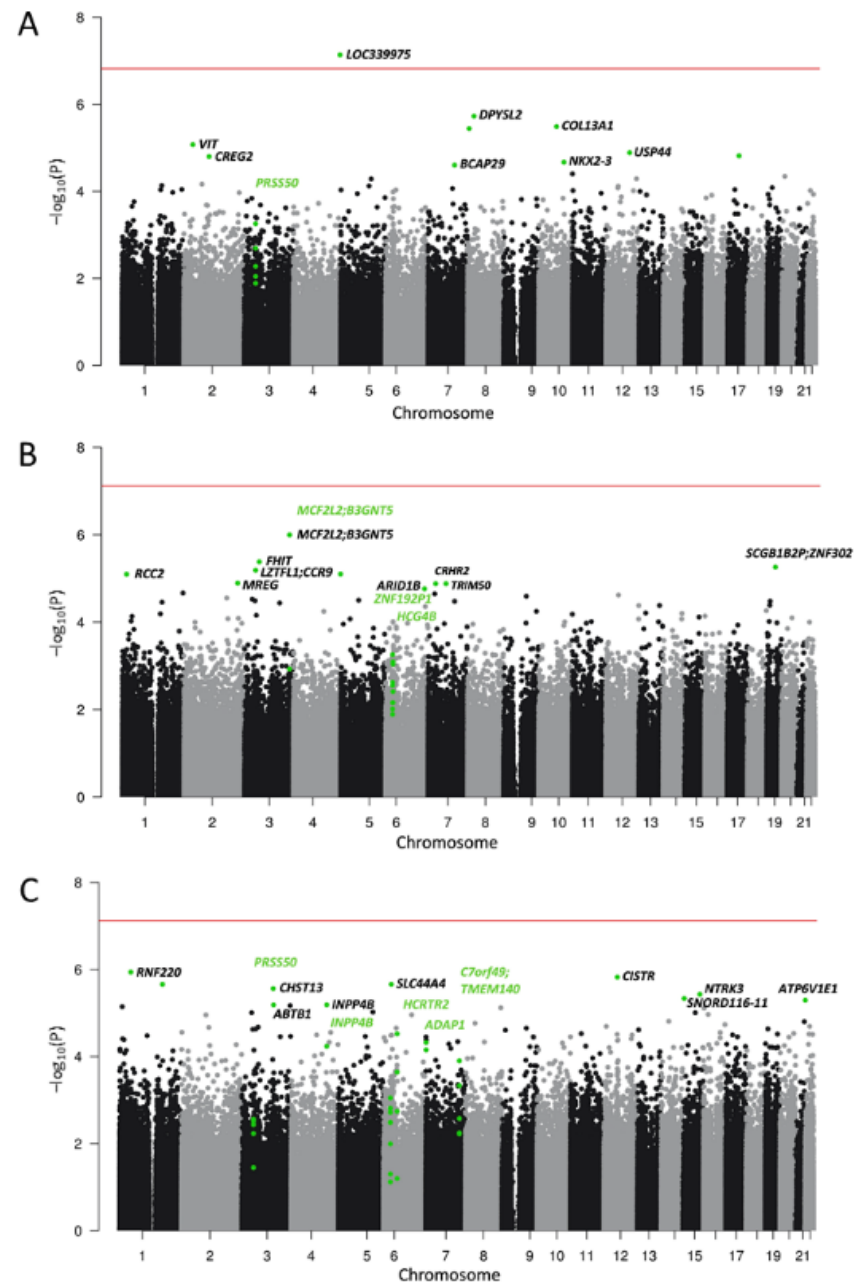
Figure 3. Manhattan plots for the EWAS of smoking in ( A ) anterior cingulate cortex (ACC), ( B ) Brodmann Area 9 (BA9), and ( C ) the ventral striatum (VS). Top 10 smoking-associated CpG sites for each region and CpG sites contributing to differentially methylated regions (DMRs) are highlighted in green. Annotation to gene names was performed where possible. Names of genes harboring a DMR are highlighted in green. The horizontal line depicts epigenome-wide significance (5% FDR, for further information, see Supplementary Table